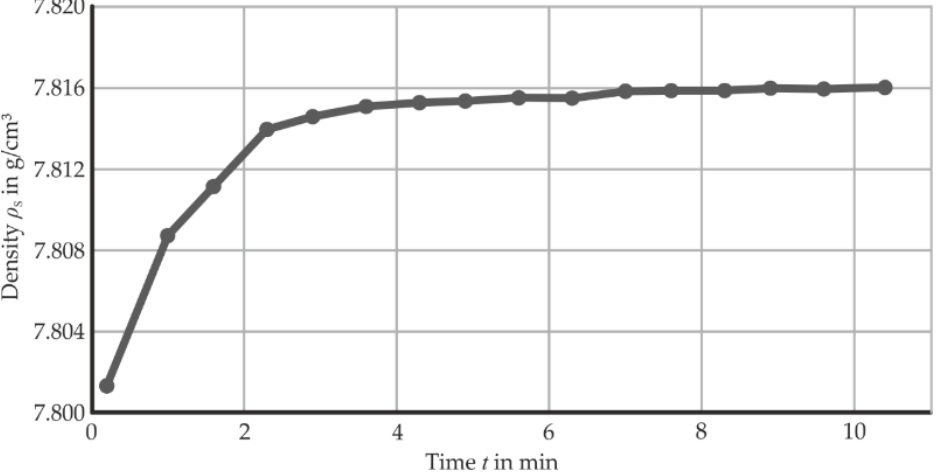
Figure 12. Density fluctuation due to bubbles and alternating temperature over time for an unbent sheet.